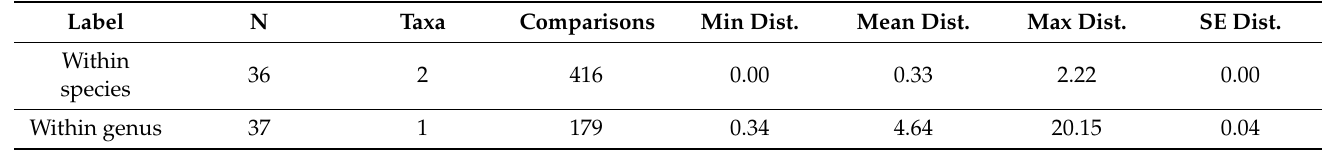
Table 2. Sequence divergence distribution at each taxonomic level examined. To avoid confusion, in this analysis continental vs. island specimens were labelled as two different species, Mastigodiaptomus ha vs. Mastigodiaptomus sp. (= M. ha -island population), to perform a comparison between the